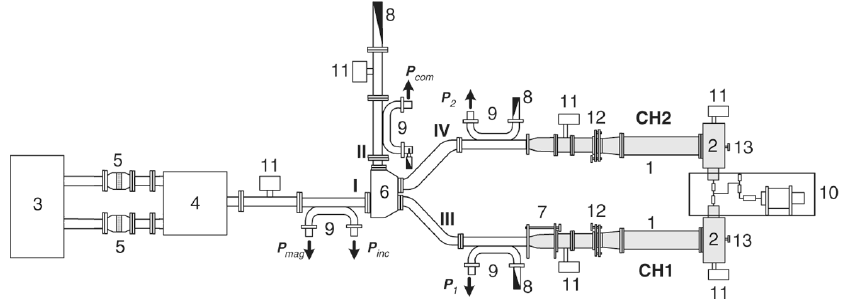
FIG. 12. Schematic diagram of the experimental setup for tests of a two-channel microwave compressor: (1) single-channel of the compressor; (2) plasma switch, based on mode conversion; (3) magnicon; (4) combiner; (5) output window; (6) single-mode 3-dB hybrid coupler; (7) phase shifter; (8) matched load; (9) 55.5-dB directional coupler; (10) high-voltage pulse generator; (11) ion pump; (12) movable taper; (13) adjusting